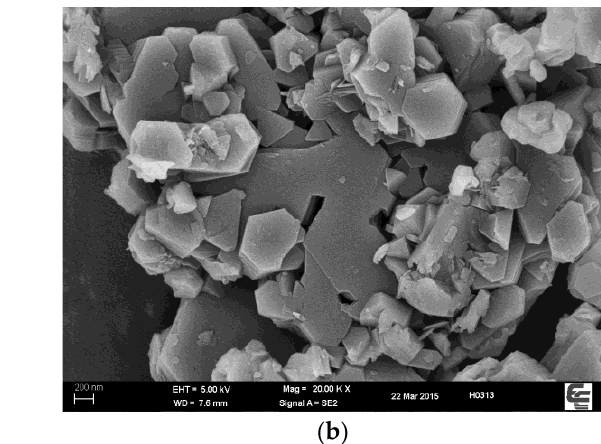
10 of 15 Figure 9. CO 2 -TPD diagrams of MgAl2.0 and its crosslinked counterpart (CL-MgAl2.0). Table 3. Desorption peak temperature and area of MgAl2.0 and its crosslinked counterpart. LDHs